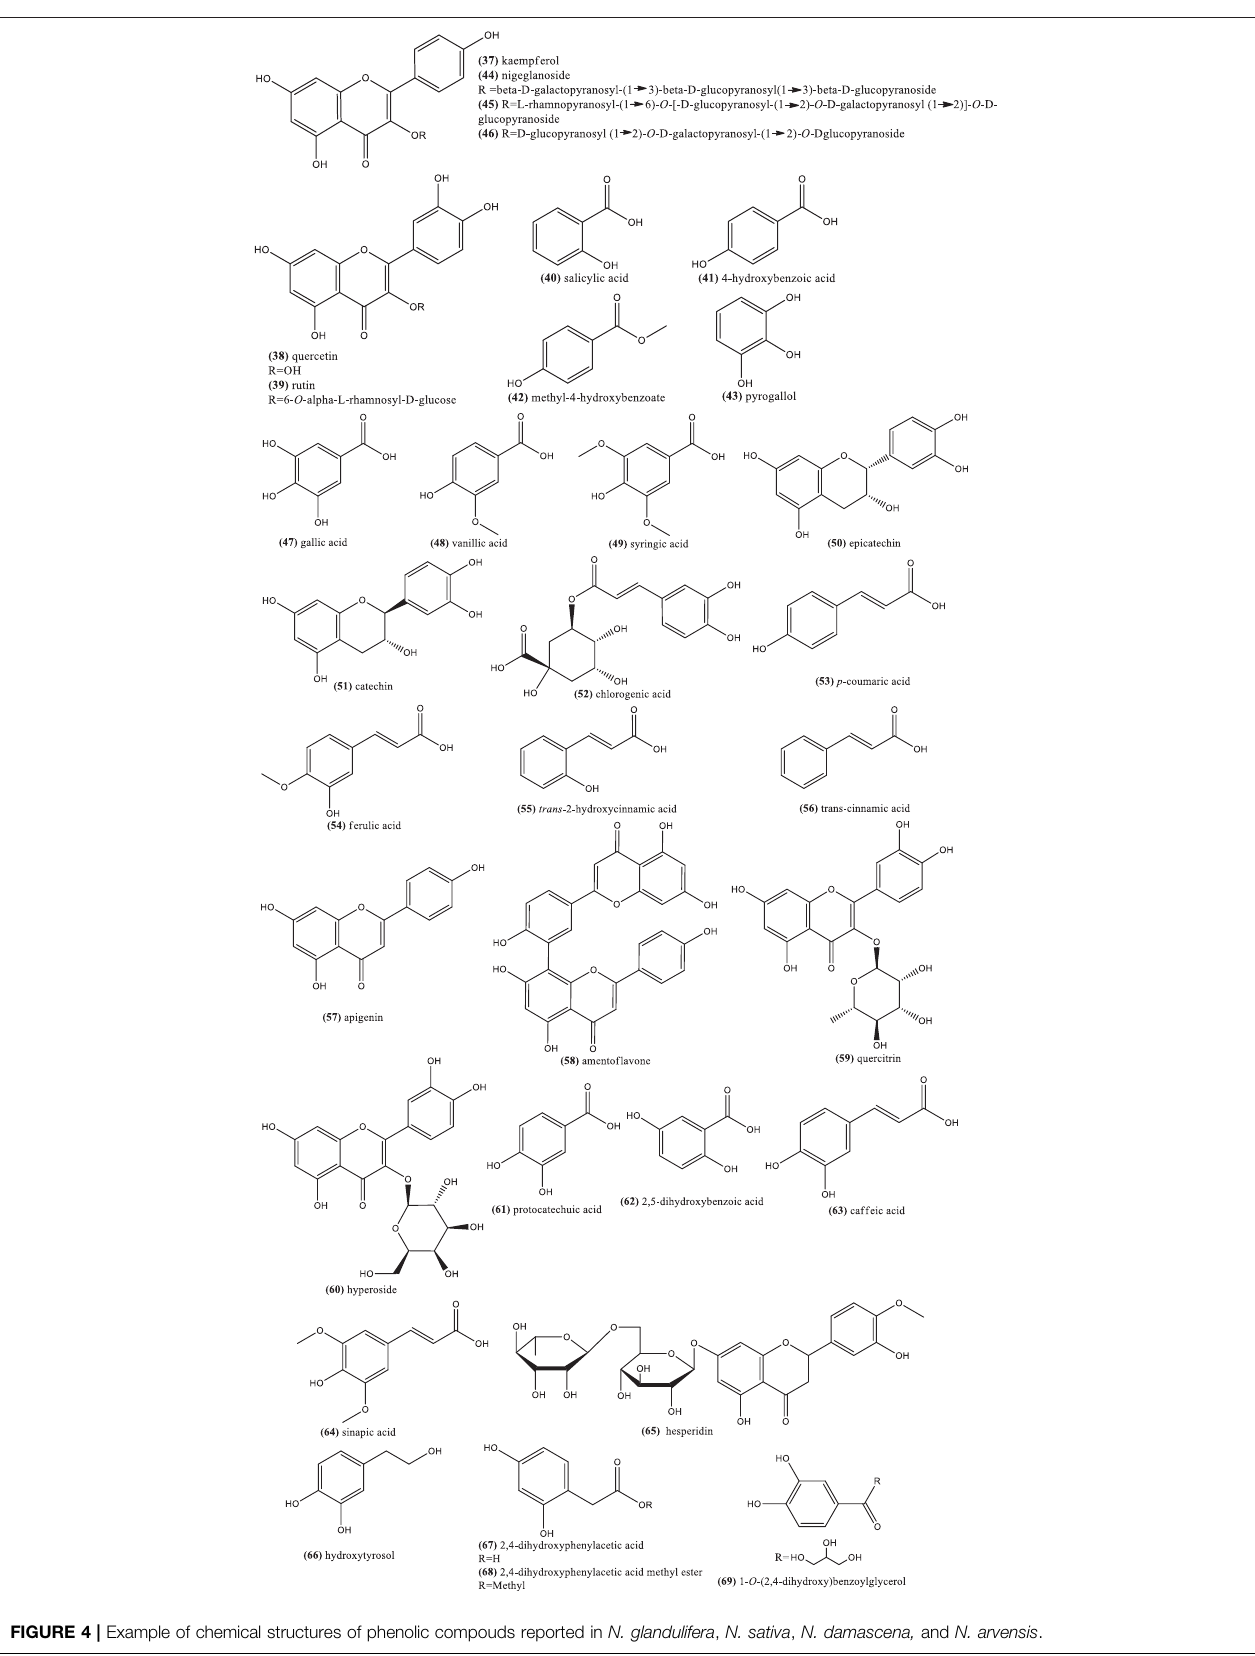
FIGURE 4 | Example of chemical structures of phenolic compouds reported in N. glandulifera , N. sativa , N. damascena, and N. arvensis .